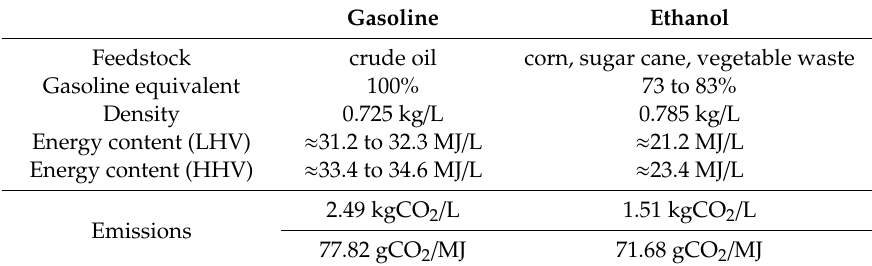
Table 1. Gasoline versus ethanol [6,7]. (LHV: lower heating value; HHV: higher heating